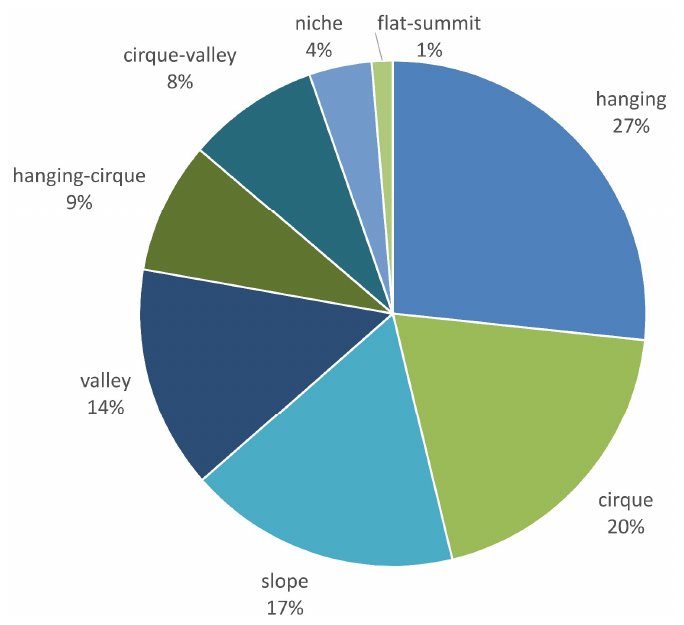
Figure 5. Distribution of the number of glaciers in 2010 by morphological types.